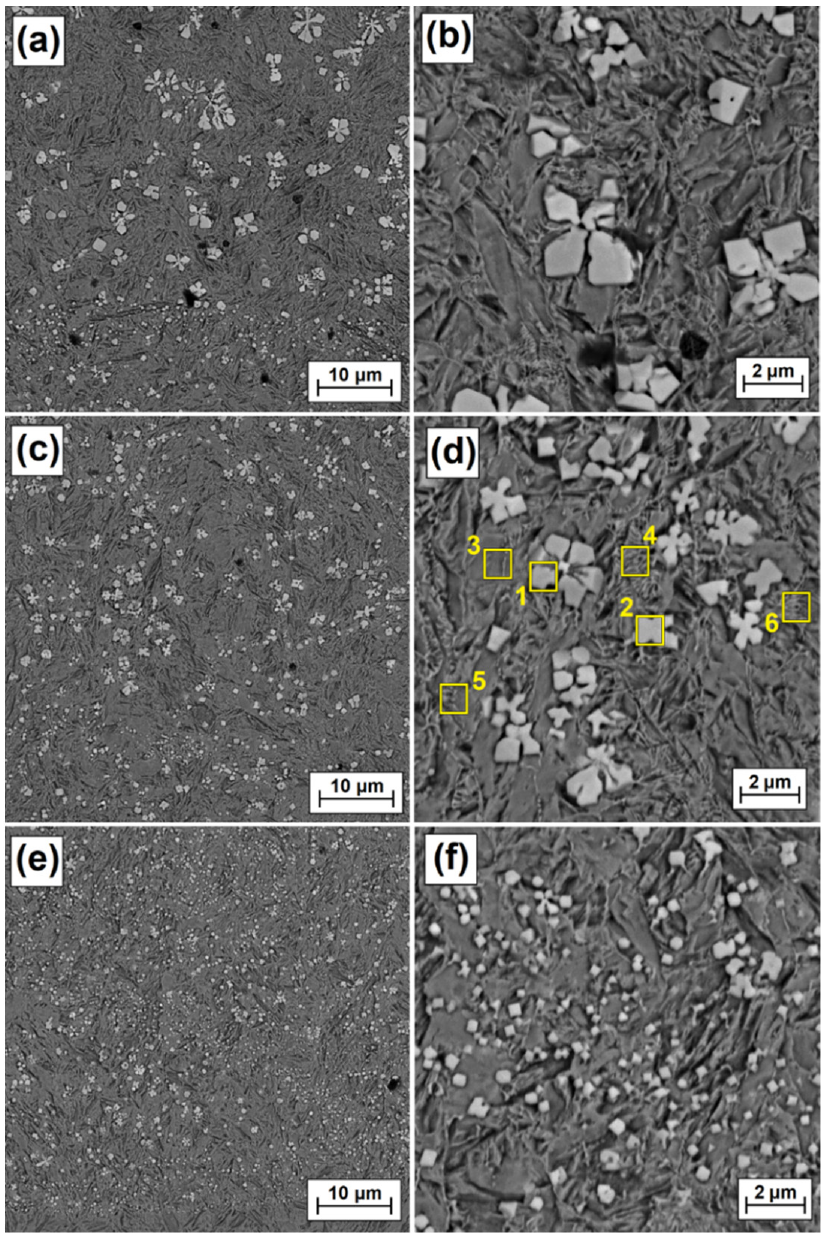
Figure 9. Melted zone microstructure of Fe/ZrC coatings produced using laser beam power of 1100 W; subsurface area ( a ), magnification of subsurface area ( b ), middle area ( c ), magnification of middle area ( d ), sub-substrate area ( e ), magnification sub-substrate area ( f ). As laser beam power increased, the reduction in carbide precipitate dimensions was observed more and more clearly. The use of laser beam power of 900 W contributed to a significant reduction in the amount of dendritic carbide precipitates in the subsurface zone (Figure 8a). Separations in the form of polygons (Figure 8b) or stars are prevalent there. In the area located in the central part of the remelted zone (Figure 8c), these separations are small, not exceeding 2 µ m (Figure 8d). Local occurrence of eutectics was observed between the separations. In the zone farthest from the coating surface (Figure 8e), i.e., where the substrate acts as a cooler, secondary carbide precipitates are the smallest, with their dimensions often not even reaching 0.5 µ m. This area can be characterized as a fine dispersion composite